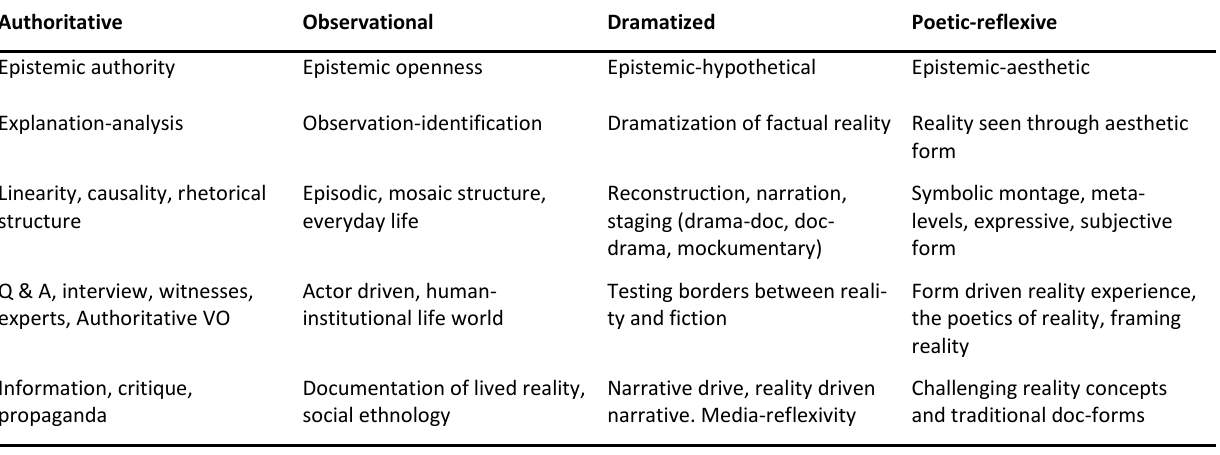
Table 1. Basic Documentary Prototypes (Bondebjerg,